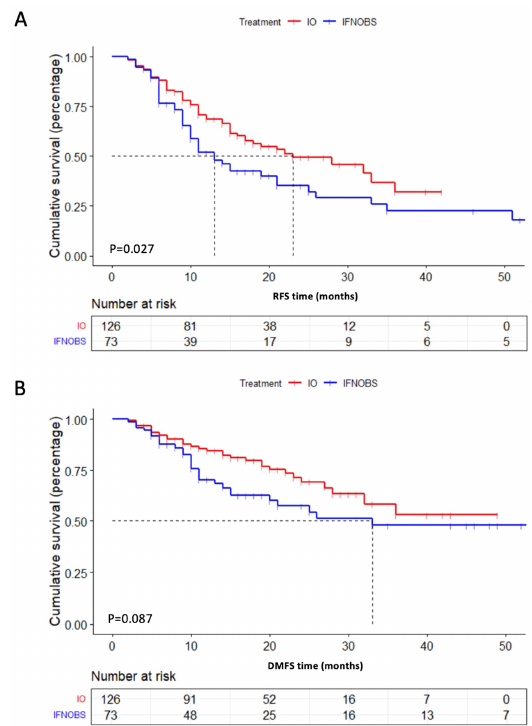
Figure 1. Kaplan–Meier curves of RFS ( A ) and DMFS ( B ) for all enrolled acral and cutaneous patients stratified by adjuvant PD-1 inhibitor treatment versus conventional treatment (IFN+OBS). No notable difference was observed in the RFS between the PD-1 inhibitor group and the IFN group (23 months vs. 15 months, p = 0.170) (Table S1). The overall survival (OS) was significantly longer for patients treated with PD-1 inhibitors than for those receiving IFN ( p = 0.160) (Figure 2A). The RFS was 23 months (95% CI: 17-NA) for the PD-1 inhibitor group and 15 months (95% CI: 11–33) for the IFN group ( p = 0.170) (Figure 2B). The among- group differences in RFS were consistent with observations across subgroups based on baseline characteristics shown in the forest plot (Figure 3). The data show that most sub- groups could benefit from adjuvant PD-1 inhibitors versus conventional treatment groups (IFN+OBS).